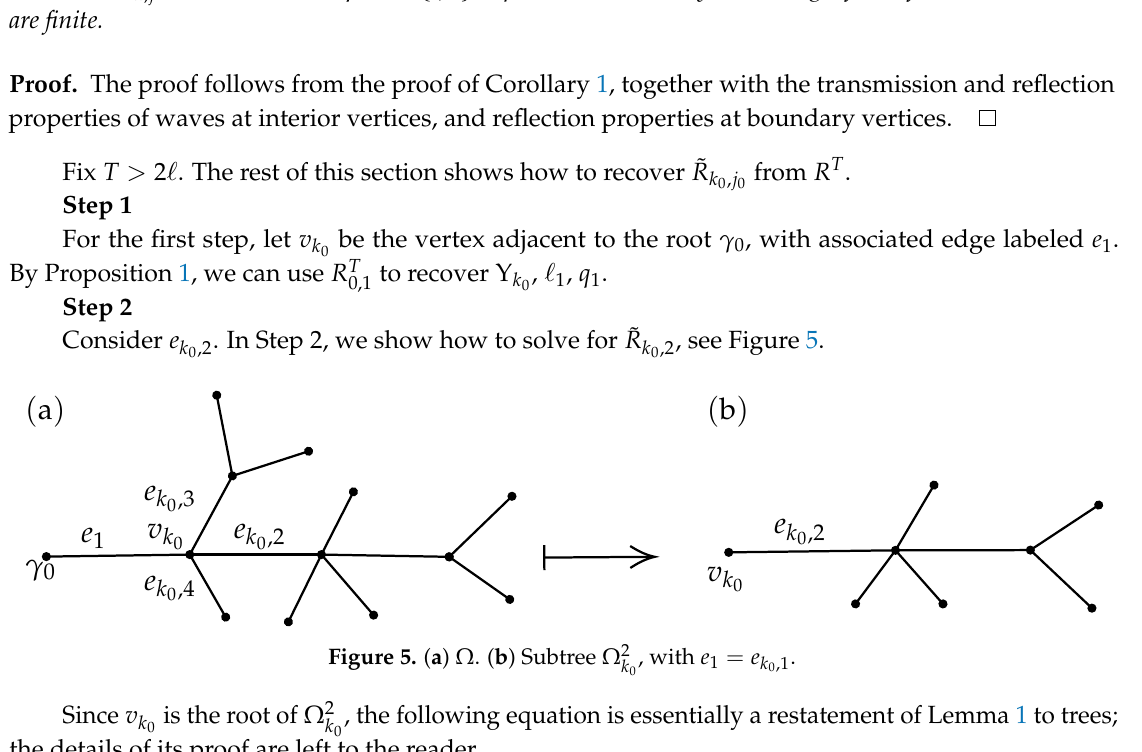
Figure 5. ( a ) Ω . ( b ) Subtree Ω 2